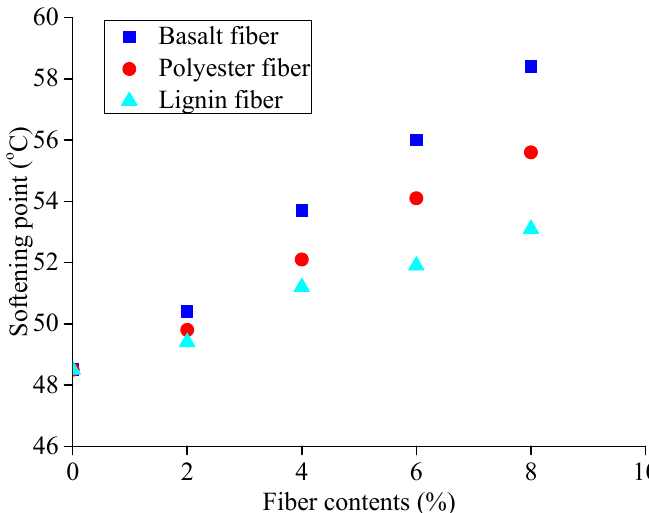
Figure 10. Softening point test results for three kinds of fiber-reinforced asphalt binder.